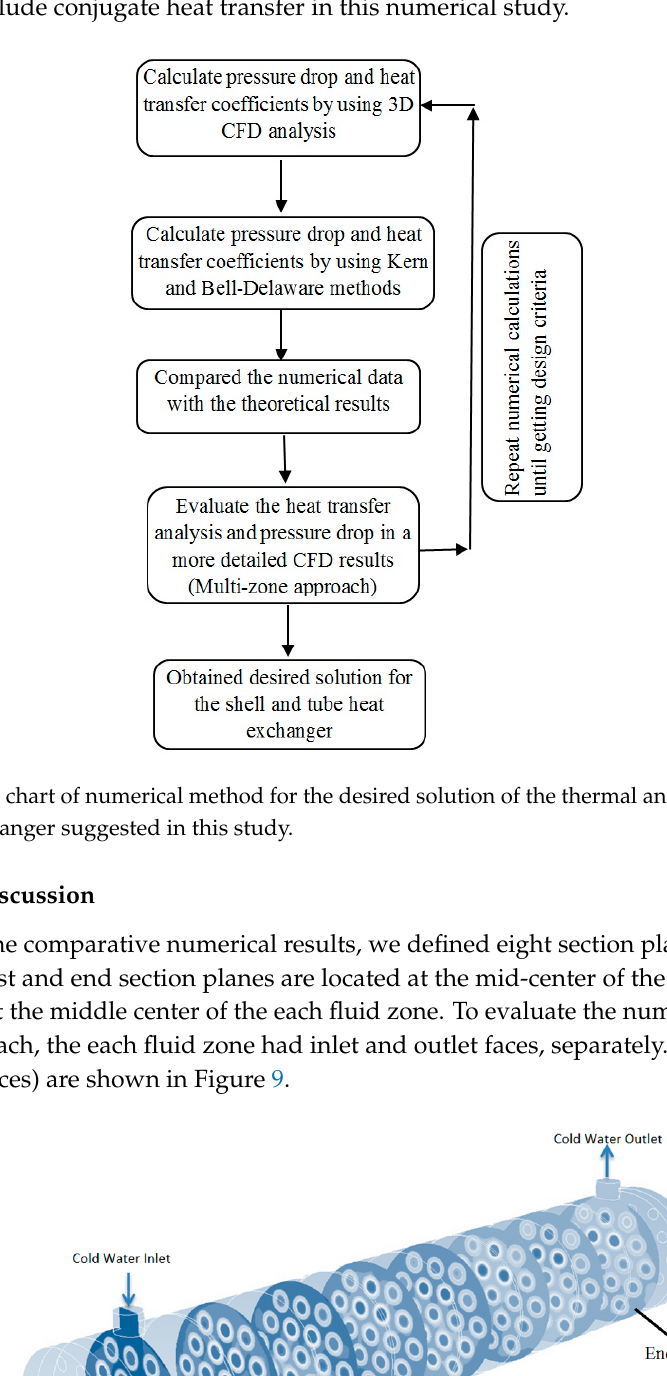
Figure 9. Window surfaces located between two adjacent fluid zones.